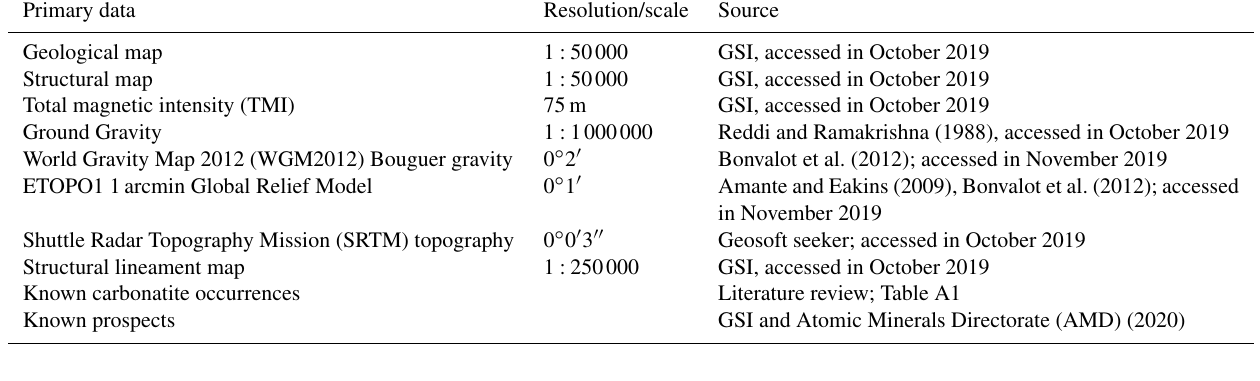
Table 1. A list of primary data available for the study area.